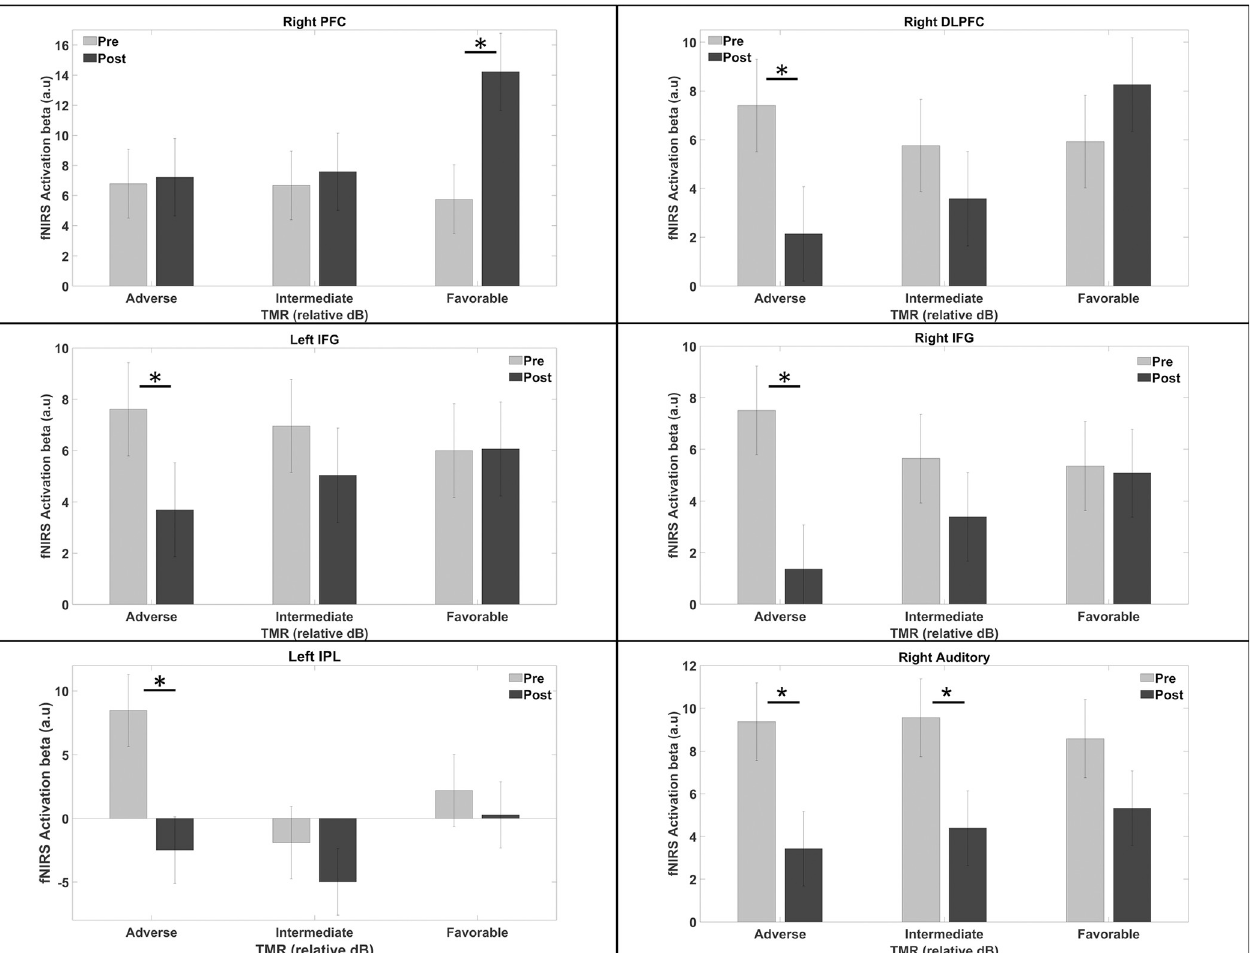
Fig 8. Effects of training on cortical activations for each TMR condition. Pre: Pre-training session; Post: post-training session. � p < 0.05 (FDR corrected).